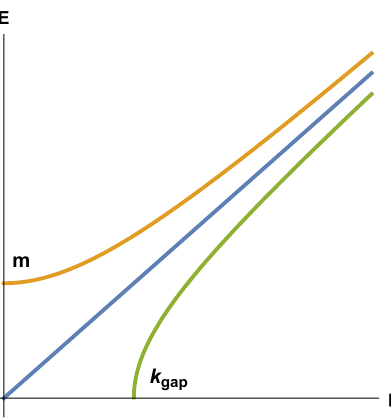
Figure 2 . Possible dispersion relations and dependencies of energy E on momentum p . Top curve shows the dispersion relation for a massive particle. Middle curve shows gapless dispersion relation for a massless particle (photon) or a phonon in solids. Bottom curve shows the dispersion relation (1.3) with the gap in k -space, illustrating the results of ref.